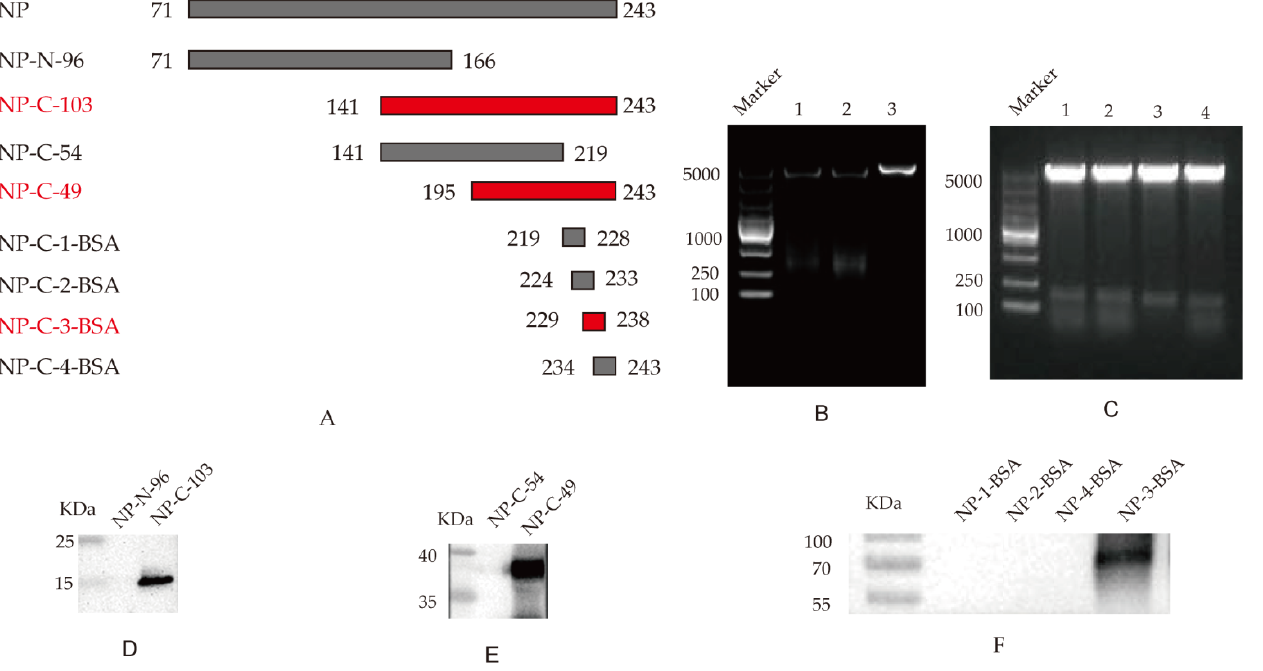
Figure 3. Identification of B-cell determinants special to 4F5 mAb: ( A ) Schematic diagram of NP epitope identification; ( B ) Identification of recombinant plasmids pET-28a-NP-N-96 and pET-28a-NP-C-103 by double enzyme digestion. Lanes 1, pET-28a-NP-N-96; lanes 2, pET-28a-NP-C-103; lanes 3, pET-28a vector control; ( C ) Identification of recombinant plasmids pEGX-4T-1-NP-C-54 and pEGX-4T-1-NP-C-49 by enzyme double digestion. Lanes 1–2, pET-28a-NP-C-54; lanes 3–4, pET-28a-NP-C-49; ( D ) Identification of the truncated NP-N-96 and NP-C-103 with mAb 4F5 following Western blot analysis; ( E ) Identification of the truncated NP-C-54 and NP-C-49 with mAb 4F5 following Western blot analysis; ( F ) Identification of the four coupled peptides with 4F5 mAb.